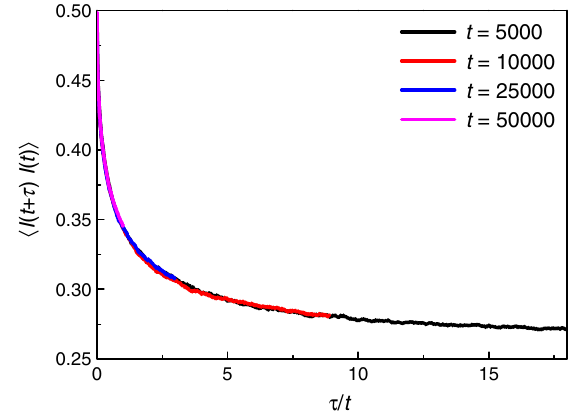
FIG. 4 (color online). Aging correlation function for the blinking quantum dots. The plots were obtained from numerical ¼ 1 and μ ¼ 0 . 6 . Since the Lévy walk simulations with t c correlation function is of the usual aging type ( ν ¼ 2 ), no rescaling is necessary for the curves to collapse onto a single one. Integrating this curve, we obtain the coefficient D 2 ≃ 0 . 043 in good agreement with the result D 2 ¼ 0 . 05 from Eq.